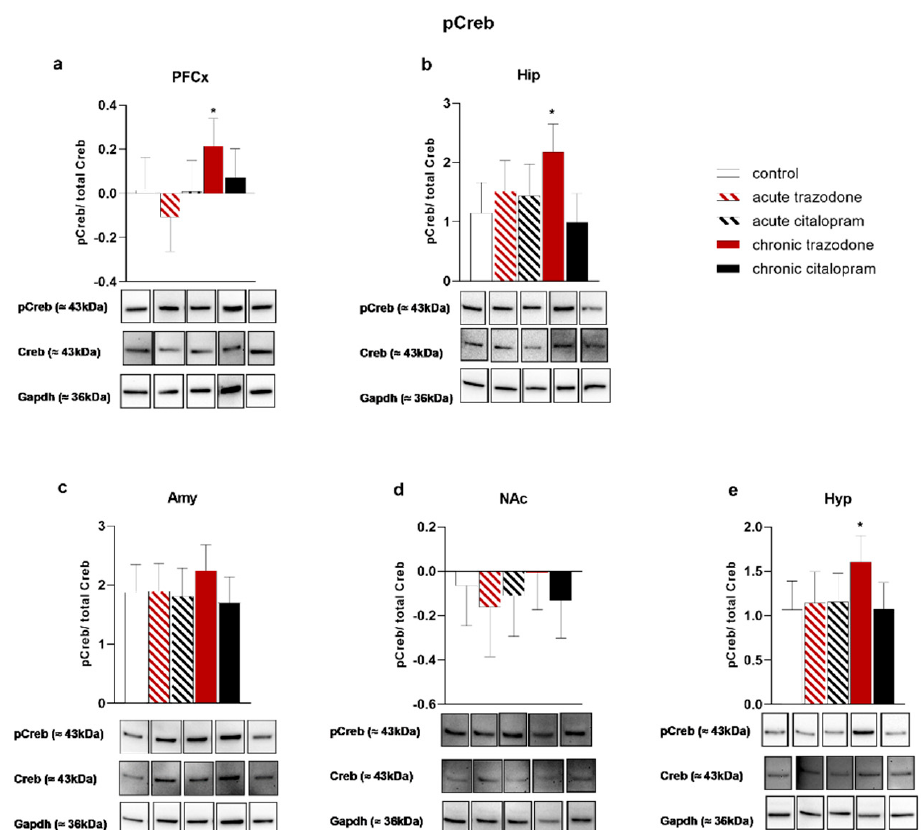
Figure 6. Protein levels of phospho-CREB/total CREB in the PFCx ( a ), Hip ( b ), Amy ( c ), NAc ( d ), and Hyp ( e ) after acute or chronic treatment with trazodone, citalopram, or vehicle. The least square predicted means with 95% confidence intervals are plotted. Data were log-transformed when required to stabilise the variance and satisfy the parametric assumptions ( a , d ). Representative blots are shown in each panel; blot images are displayed in Supplementary Figure S2. *: p < 0.05 in the Planned Comparison vs. control. n = 6/group.